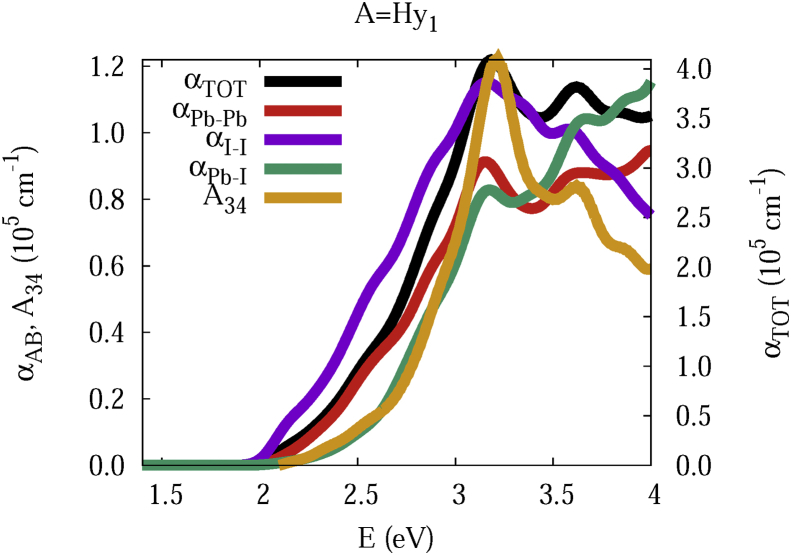
Same legend as that in Fig. 1, but for A = Hy1.